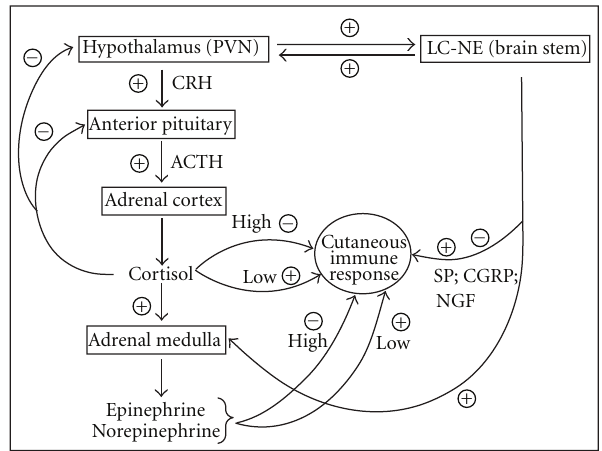
Figure 1: A schematic representation of the hypothalamic-pituitary-adrenal (HPA) axis and sympathetic nervous interaction with the cutaneous immune system. Stress signals induce release of hormones, including corticotropin-releasing hormone (CRH) from the paraventricular nucleus (PVN) of the hypothalamus. CRH induces adrenocorticotropic hormone (ACTH) release from the anterior pituitary [20]. In turn, ACTH regulates glucocorticoid secretion from the adrenal cortex [22]. Cortisol has several functions including negative feedback of the hypothalamus and anterior pituitary and induces epinephrine and norepinephrine from the adrenal medulla [23]. Glucocorticoids, such as cortisol, as well as epinephrine and norepinephrine may enhance cutaneous immune responses at low concentrations and suppress immune responses at high concentrations [5, 28]. Stress signals also stimulate the locus coeruleus (LC) norepinephrine cells (NE) of the sympathetic nervous system [18]. Neuropeptide products of the sympathetic response (substance P (SP), calcitonin gene-related peptide (CGRP), and cutaneous nerve growth factor (NGF)) have been shown to be proinflammatory and anti- inflammatory dependent on the immune cell type [29–34]. There also exists a positive, reverberatory feedback loop between the HPA axis and LC-NE [18, 21]. Results show that HPA and sympathetic stress responses both modify the cutaneous immune